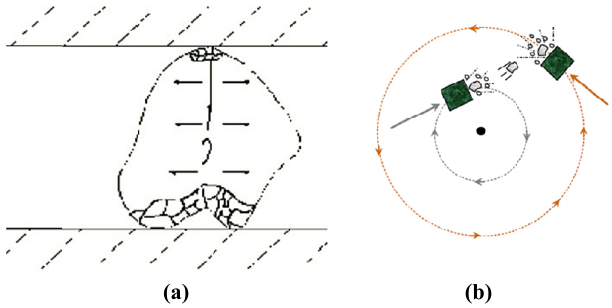
Fig. 7. Size reduction mechanism of (a) jaw crushing and (b) cage milling